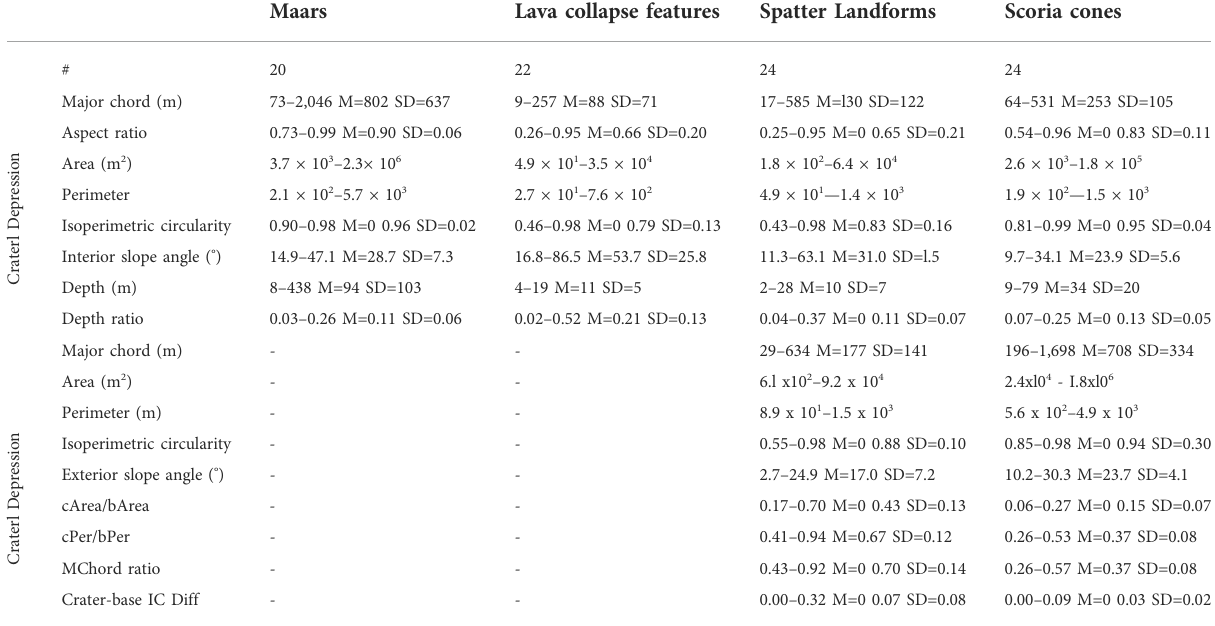
TABLE 2 SMILES database